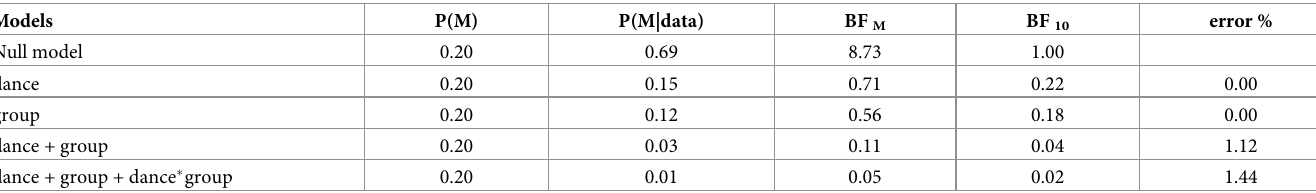
Table 7. Comparison of Bayes models: Dance &